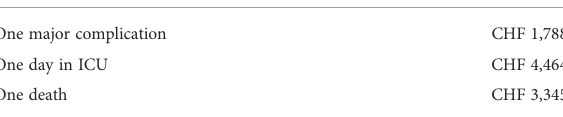
TABLE 2 Cost to prevent adverse outcomes within a 30-day timeframe. CHF, Swiss franc. Adverse outcome